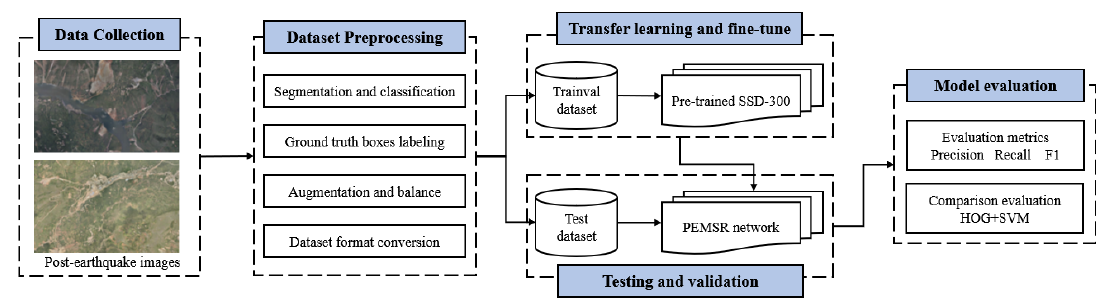
Figure 1. PEMSR model’s workflow. Trainval dataset means training and validation dataset.